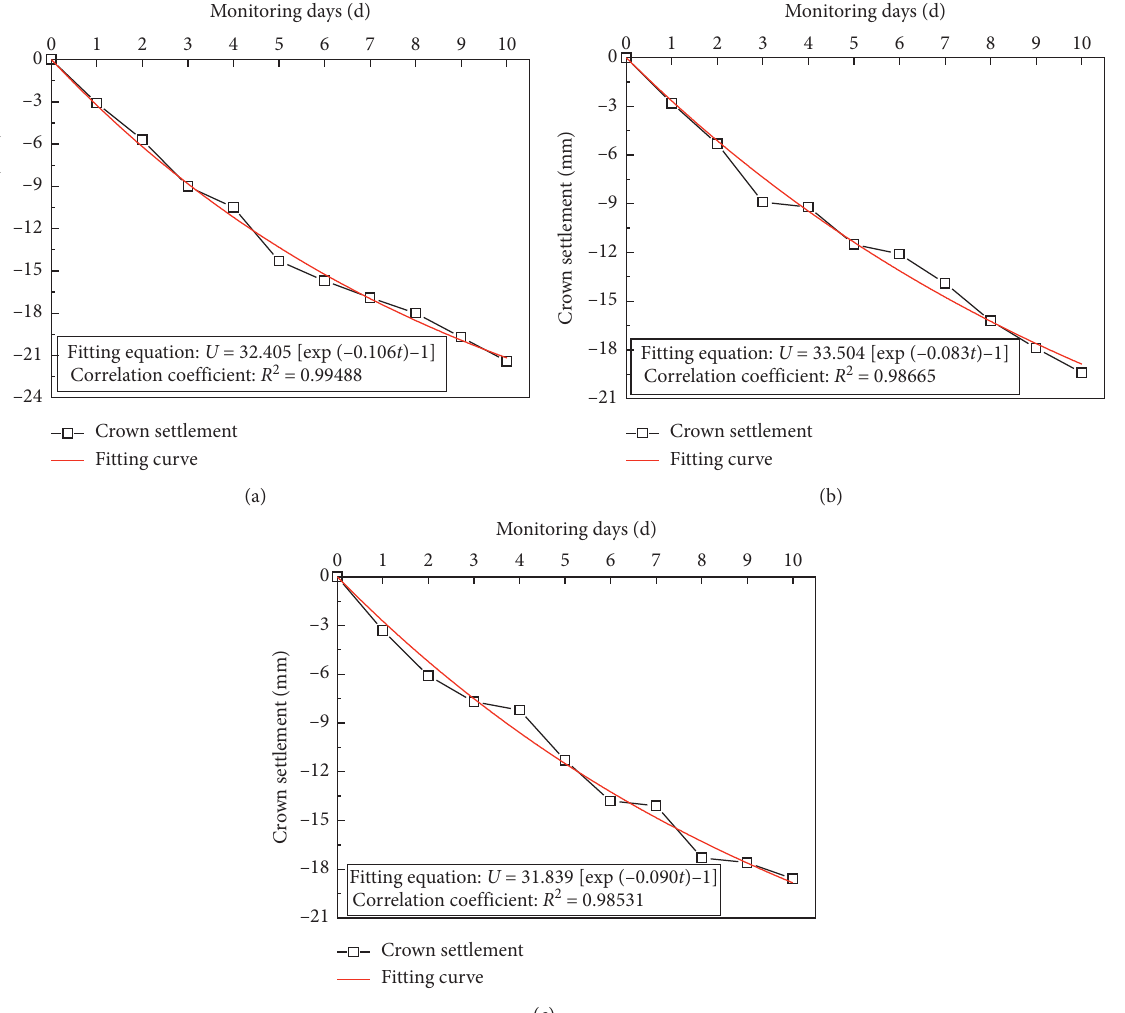
Figure 12: Monitoring data of crown settlement of initial support in three sections and fitting curve. (a) Section 1. (b) Section 2. (c) Section